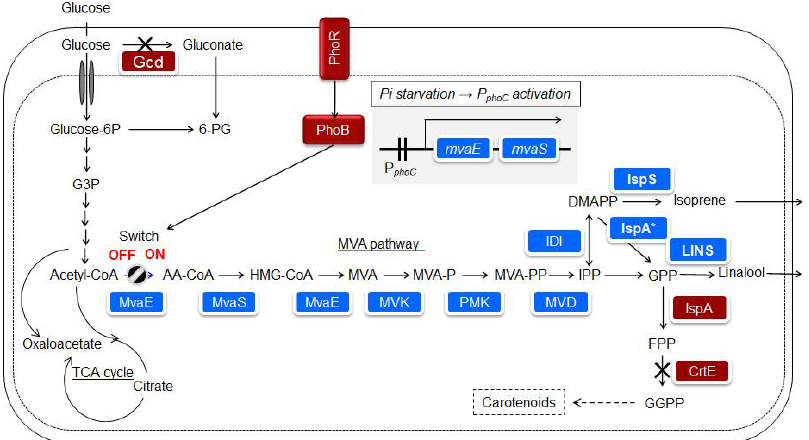
Figure 4. Biosynthetic pathway introduced into Pantoea ananatis AJ13355 to produce isoprenoids. The introduced foreign genes or enzymes are shown on a blue background. Host-derived enzymes are shown on a brown background [17].